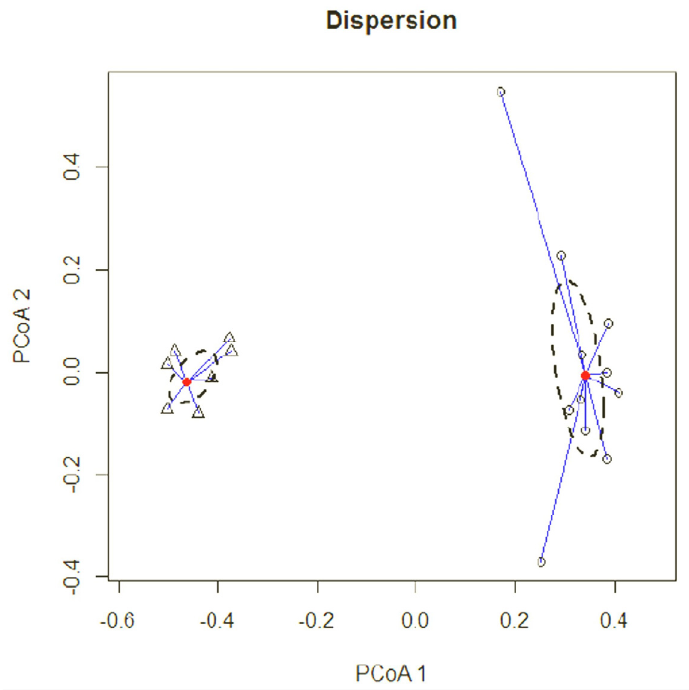
Figure 12. Scatter plot diagram of presence/absence data. The empty circles represent the Otonga sampling plots (right of diagram), the empty triangles the Otongachi sampling plots (left of dia- gram), the red dots represent the centroids. The axes PCoA1 and PCoA2 represent the first two principal components, while the dashed lines represent the 95% confidence interval.